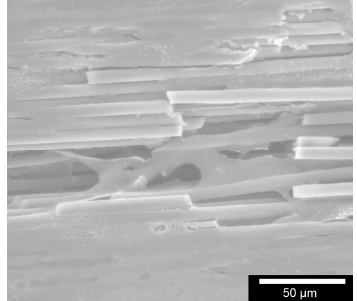
Figure 3. ESEM image to demonstrate morphological behaviour of cells on the sample structure. The circles in the images show cellular extension along the fibres. Table 2. Spectrum characteristics of energy-dispersive X-ray